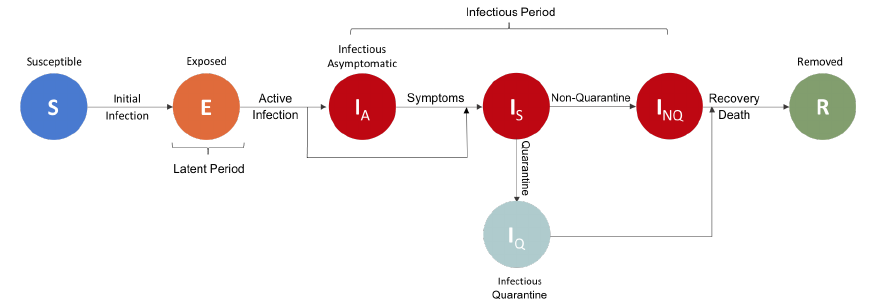
Figure 6. Extended SEIR epidemic model including additional states of Infectious Asymptomatic, Infectious Symptomatic, Quarantine, and